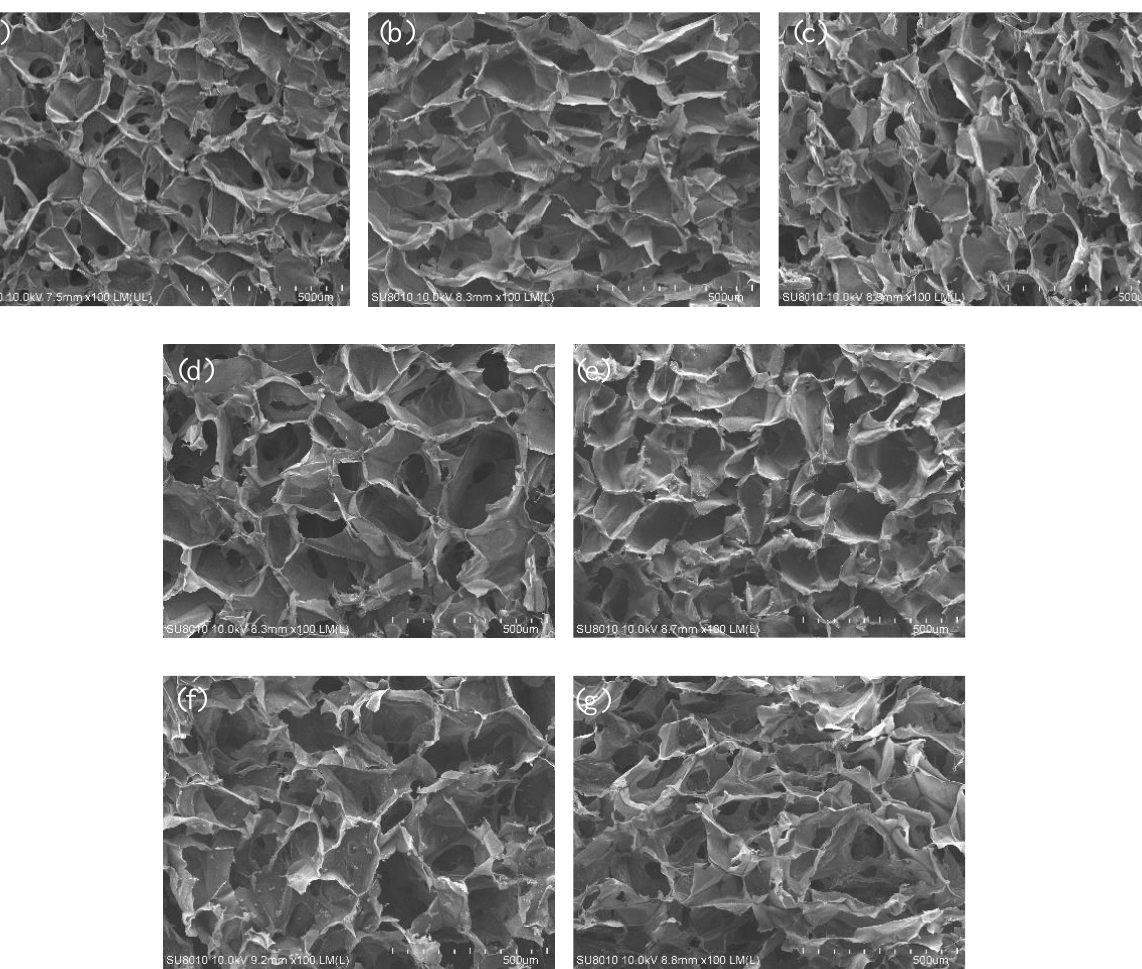
Figure 3. The SEM micrographs (100 × ) for the cross-sectional view of ( a ) Chitosan (CS), ( b ) CM41-cin, ( c ) CM21-cin, ( d ) CM11-cin, ( e ) CM41-cin-AgNPs, ( f ) CM21-cin-AgNPs, ( g ) CM11-cin-AgNPs.